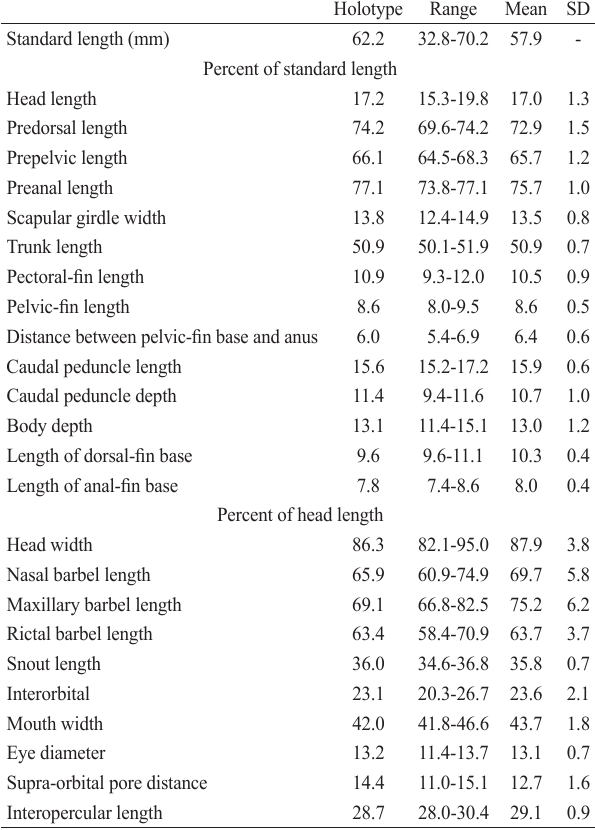
Mesethmoid large at middle portion with anterior margin slightly concave and cornuas tapering at ends (Fig. 3). Anterior cranial fontanel absent; posterior cranial fontanel small and round located in posterior portion of parieto-supraoccipital. Antorbital short and extending into autopalatine. Tendon- bone supraorbital elongate, approximately three times larger than antorbital, anterior third over the posterior portion of autopalatine (Fig. 3). Sphenotic with anterior margin pointed surpassing adjacent tip of frontal. Sphenotic, prootic, and pterosphenoid totally fused. Vomer arrow-shaped with long posterior process over parasphenoid. Parasphenoid with pointed posterior process extending over basioccipital. Weberian capsule with small lateral opening and with anterior margin fused to basioccipital. Premaxilla rectangular with 21 pointed teeth variable in size distributed in two well-defined rows and curved inward. Maxilla boomerang-shaped, shorter than premaxilla (Fig. 3). Lower jaw with 24-27 pointed teeth variable in size distributed in two or three irregular rows and curved inward. Autopalatine with anterior margin straight; medial margin with deep concavity and lateral margin concave (Fig. 2); posterior process of autopalatine extending over